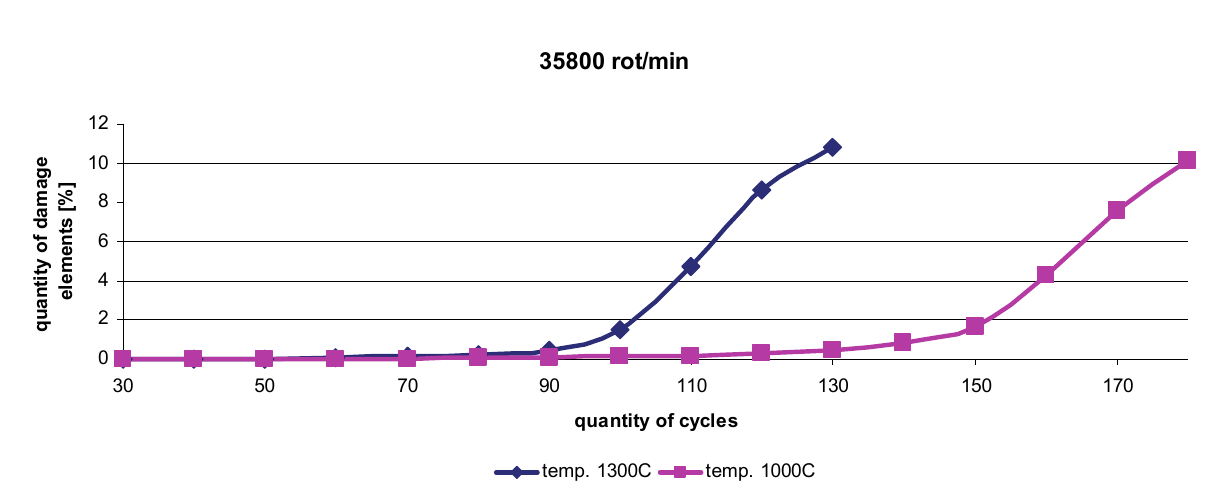
Figure 10: Quantity of the damaged elements versus the number of thermal cycles.